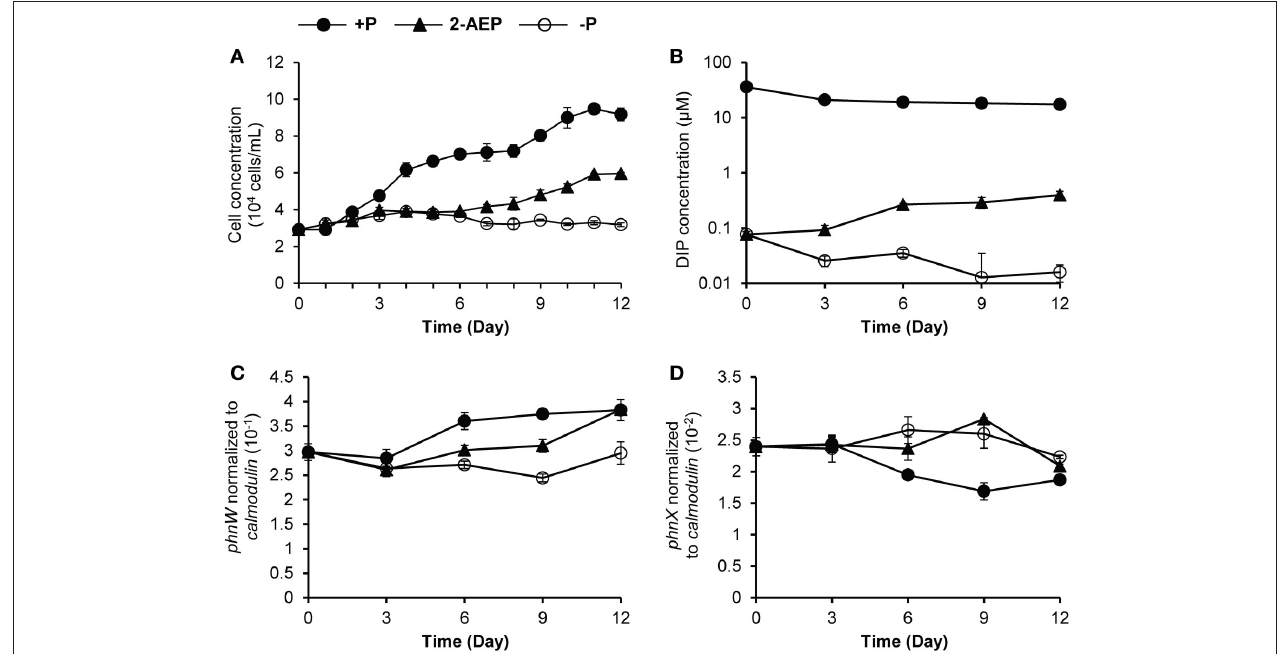
FIGURE 1 | Growth curves (A), DIP concentrations (B), and transcript abundances of phnW and phnX normalized to calmodulin (C,D) in K. veneficum grown under different P conditions. Solid circles, P-replete condition; solid triangles, P-depleted condition amended with 2-AEP; open circles, P-depleted condition.